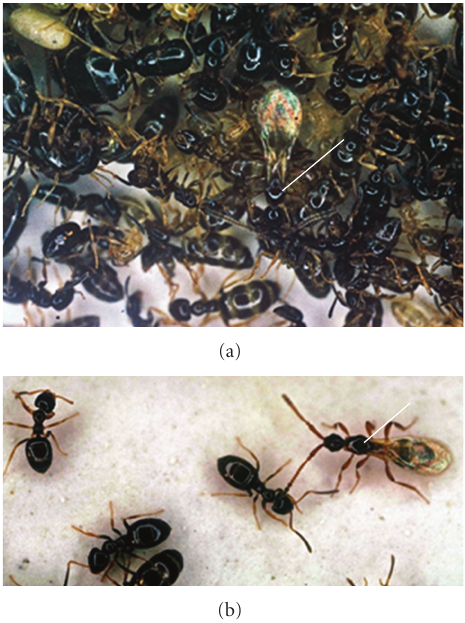
Figure 1: Winged females of the diapriid wasp, Plagiopria passerai (white pointer) in a nest of the formicine ant Plagiolepis pygmaea , just after emergence from queen pupae. Photos courtesy of L.